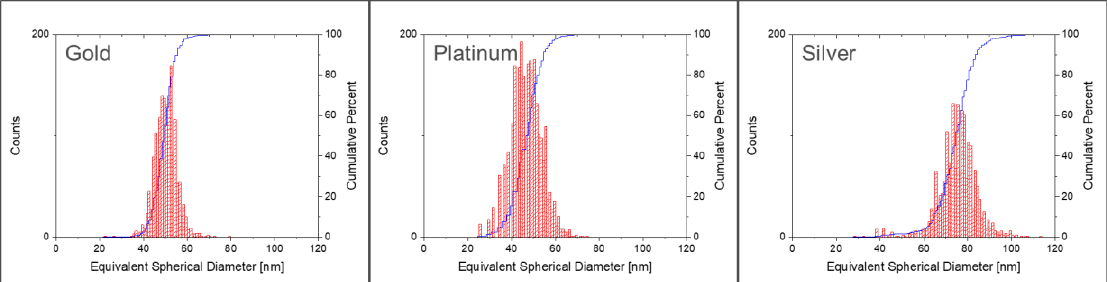
Figure 12. Number size and cumulative distributions (by number) determined with spICP-MS.